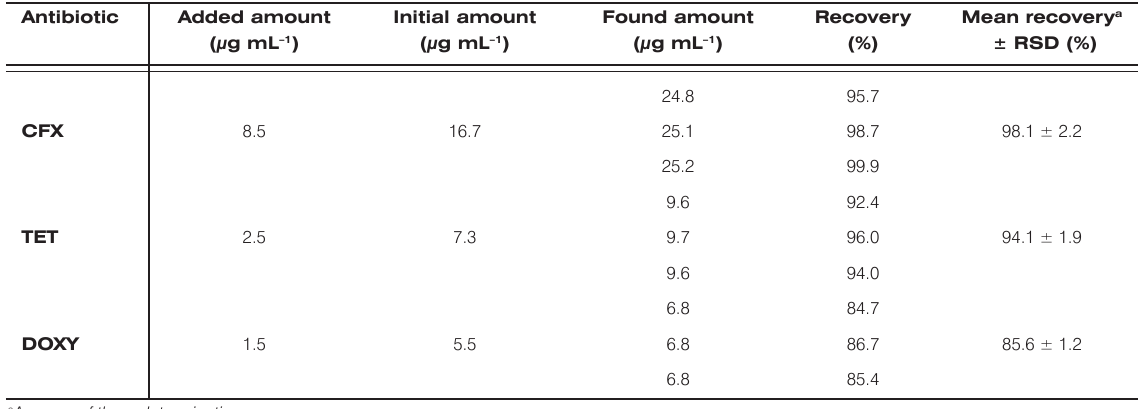
Table 6. Accuracy studies for ceftriaxone, tetracycline and doxycycline. Antibiotic